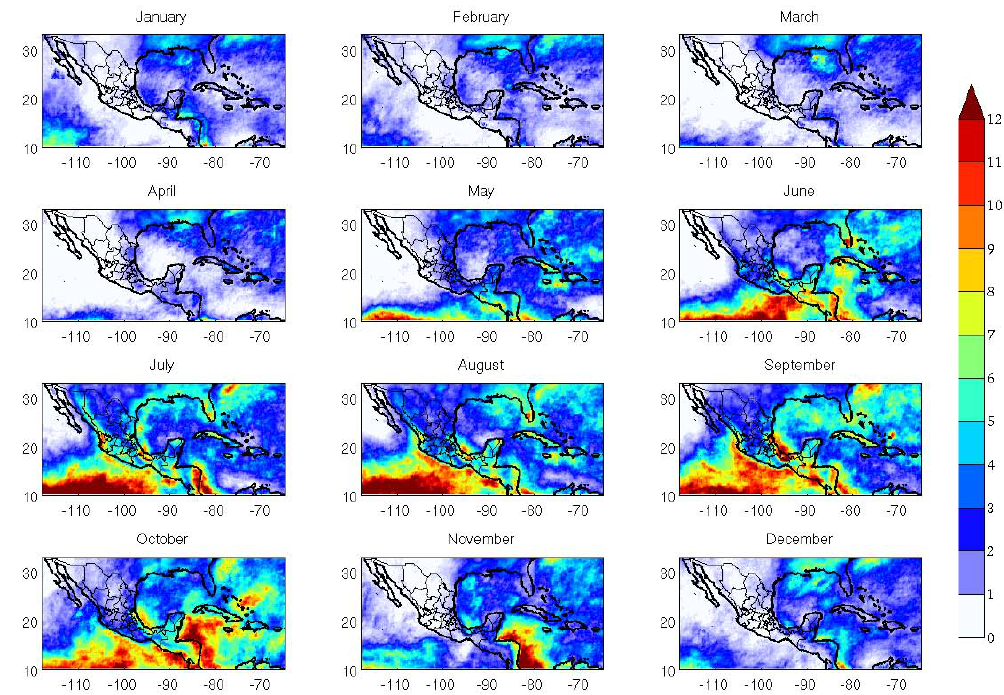
Fig. 3. Monthly distribution of rainfall [mm day − 1 ] over Mexico and adjacent oceanic regions, averaged over the years